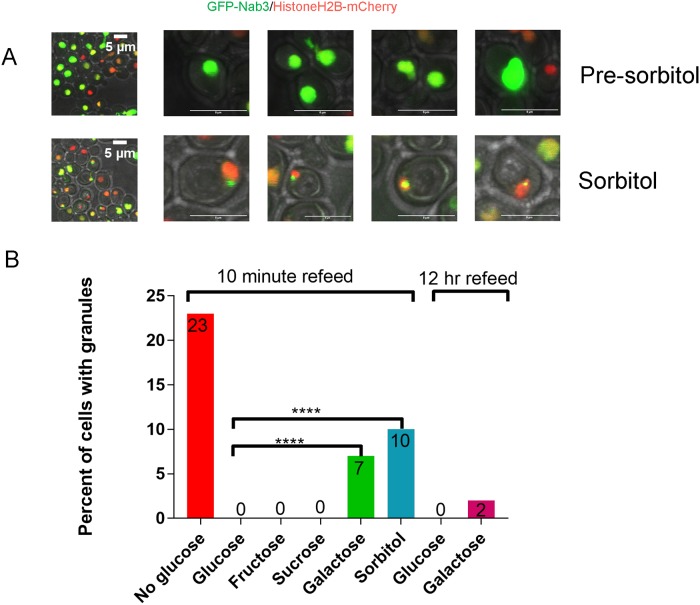
Sorbitol substitution for glucose yields Nab3-granules and does not efficiently reverse granules obtained after glucose starvation.A) DY32309 (GFP-Nab3) cells were grown in glucose, washed, imaged (“Pre-sorbitol”) or incubated for 2 hrs at 30°C with sorbitol before imaging. B) A culture of DY32309 was grown in glucose-containing medium, washed, and incubated for 18 hrs at 30°C in SC ura- leu- lacking glucose. Cells were washed, equivalent numbers were inoculated into media with the indicated sugars (2%), incubated at 30°C for 10 min or 12 hr, as indicated, imaged by confocal microscopy, and the percent of granule-containing cells were quantified. The P-values for a Fisher’s exact test of <0.0001 are indicated by ****.